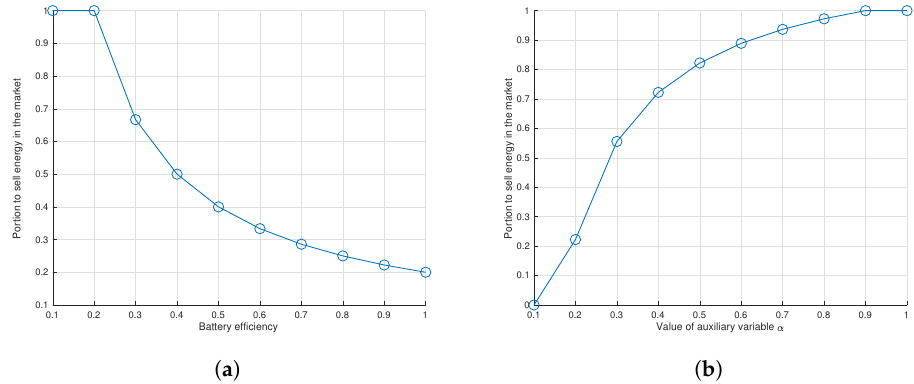
Figure 11. Determination of transaction ratio of seller according to environmental changes. ( a ) Com- pare with static system; ( b ) Compare with static system.